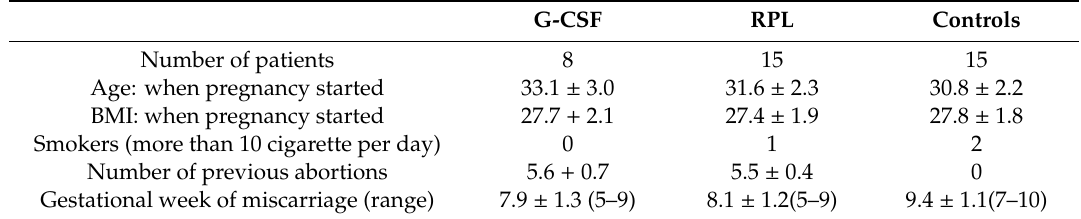
Table 1. Demographic data of three groups of patients in the study. (Data reported in mean ± SD). G-CSF RPL